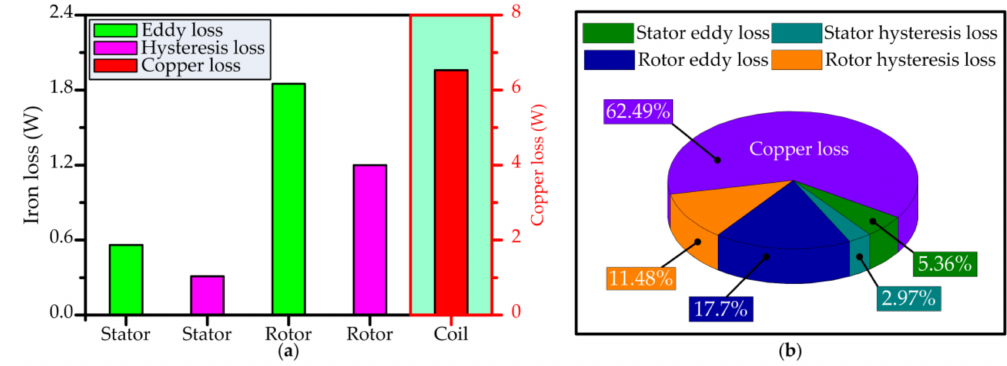
Figure 16. Loss analysis with 90 Ω resistance and at 2500 r/min: ( a ) Loss of each part; ( b ) The proportion of the loss of each part to the total